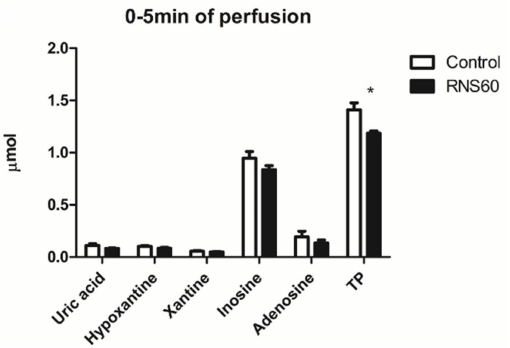
Figure 4. The release of purine catabolites from the rat heart during the initial 5 min of reperfusion after prolonged hypothermic ischemia in the control and group that received cardioplegia with RNS60. Values represent mean ± SEM (n = 5); * p < 0.02.